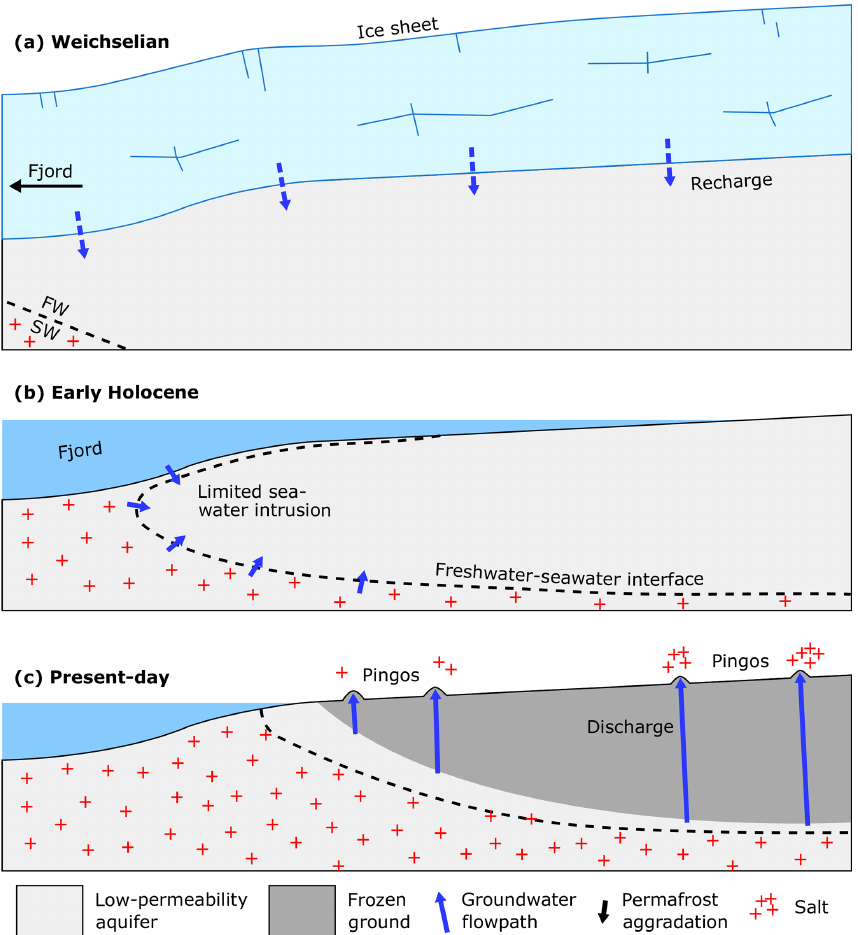
Figure 12. Possible interpretation of hydrochemical trends observed in pingo spring waters. (a) Subglacial melting from the Weichselian ice sheet recharged the groundwater system with freshwater. (b) Although covered by the sea during the Early Holocene, low-permeability rocks limited infiltration of seawater, and the fresh groundwater body persisted. (c) Due to the shallower permafrost depth towards the sea, spring water sampled in this direction holds a lower concentration of seawater